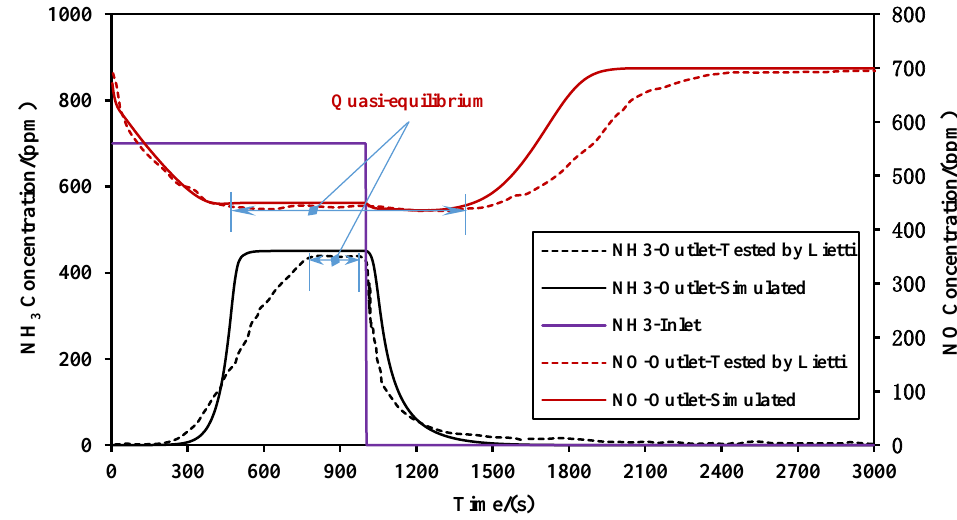
Figure 19. Simulation verification of the SCR denitration reaction process.